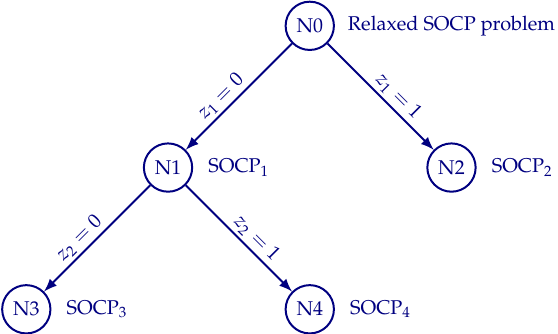
Figure 2. Exploration of the solution space with a branch and bound method to solve an MI-SOCP formulation with two binary